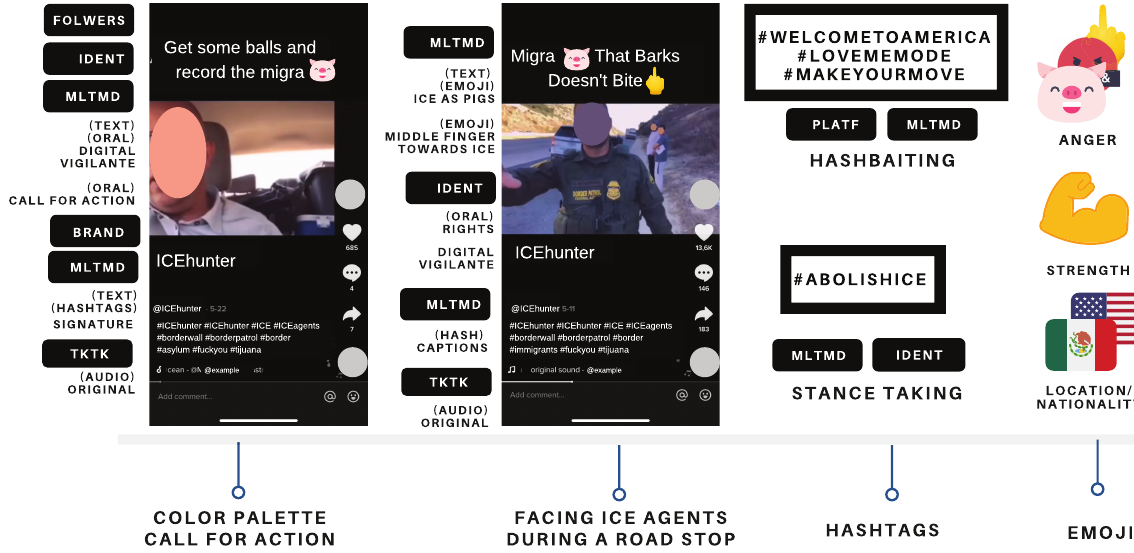
Figure 3. ICEhunter’s use of multimodal elements and TikTok